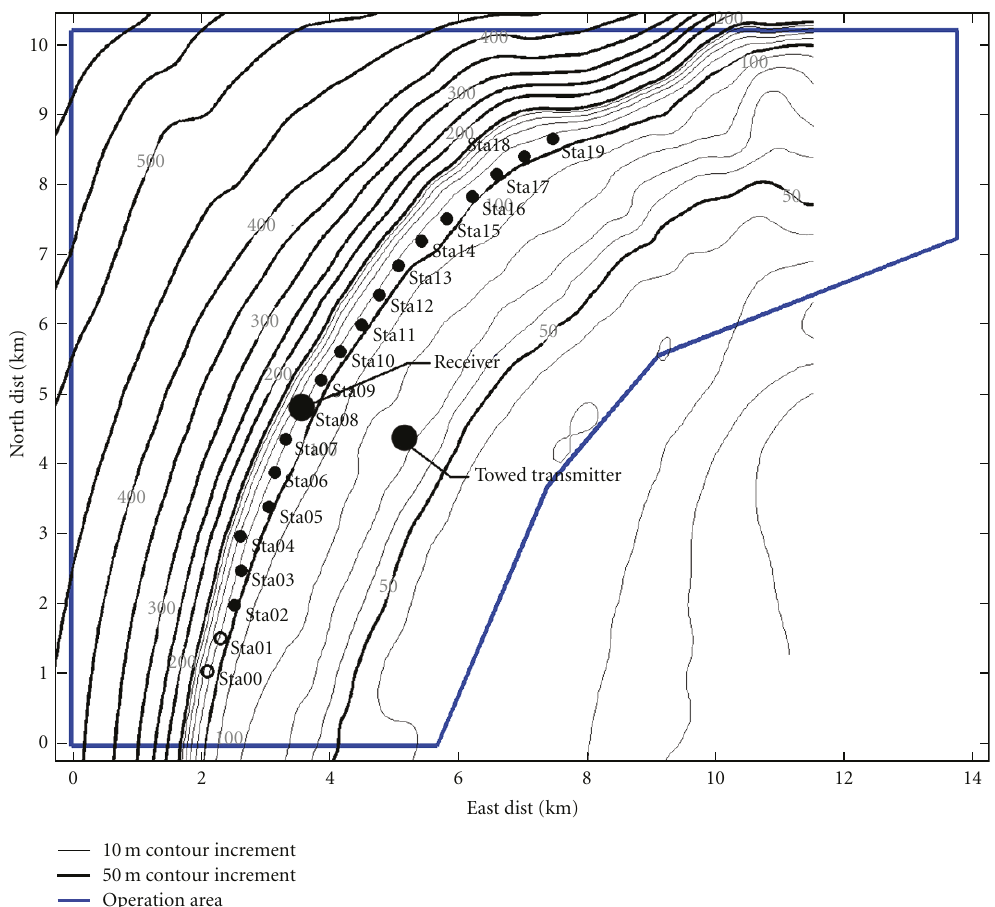
Figure 2: Bathymetry of the operation area (with the depth given in meters), receiver and transmitter positions used in the KAM08 experiment